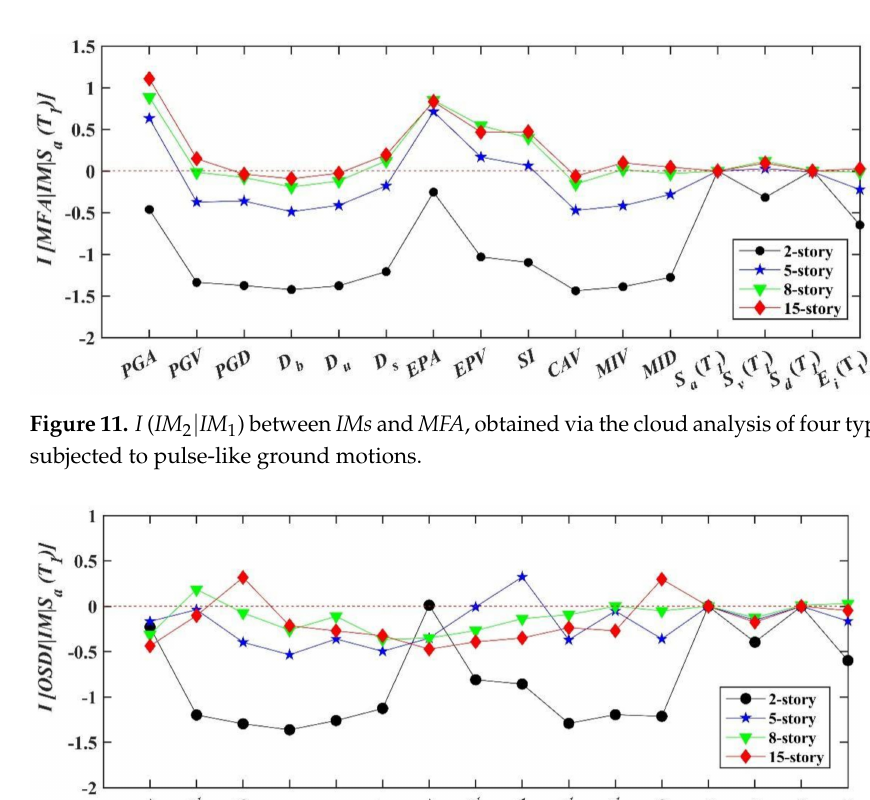
Figure 10. I ( IM 2 | IM 1 ) between IMs and MIDR , obtained via the cloud analysis of four typical structures subjected to pulse-like ground motions.